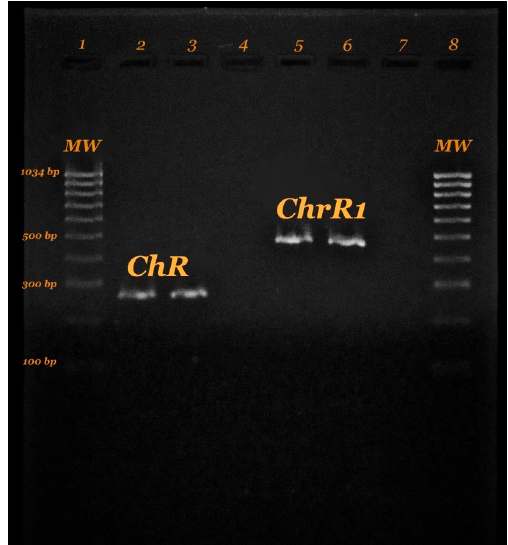
Figure 6. Chromate reductase in this study. Lane 1. 100 bp DNA Ladder-Thermo Fisher. Lanes 2–3. Gene positive ChR Patra et al. Lane 4. Negative Control. Lanes 5–6. Gene positive ChrR1 (Designed this study). Lane 7. Reactive Control. Lane 8. 100 bp DNA Ladder-Thermo Fisher.